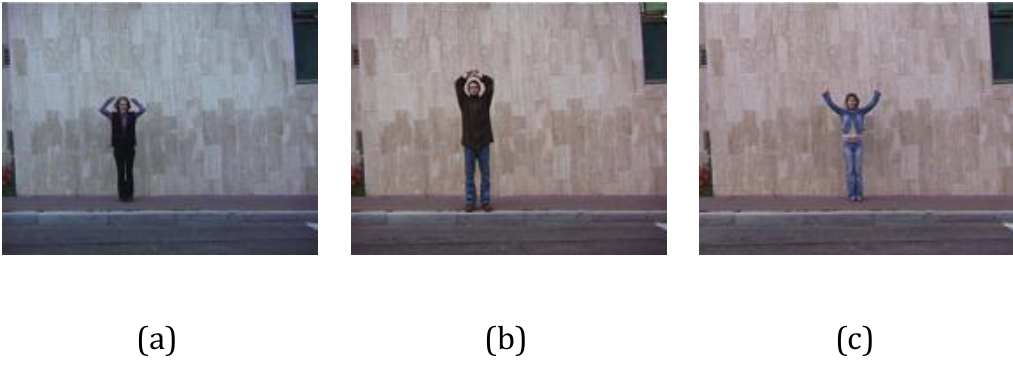
Figure 12. Abnormal “BHTW” Actions. ( a ) Un-Classification example; ( b , c ) Misclassification examples.